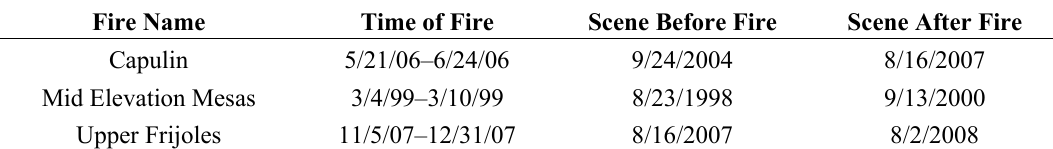
Table 1. Fire event and Landsat TM5 scene